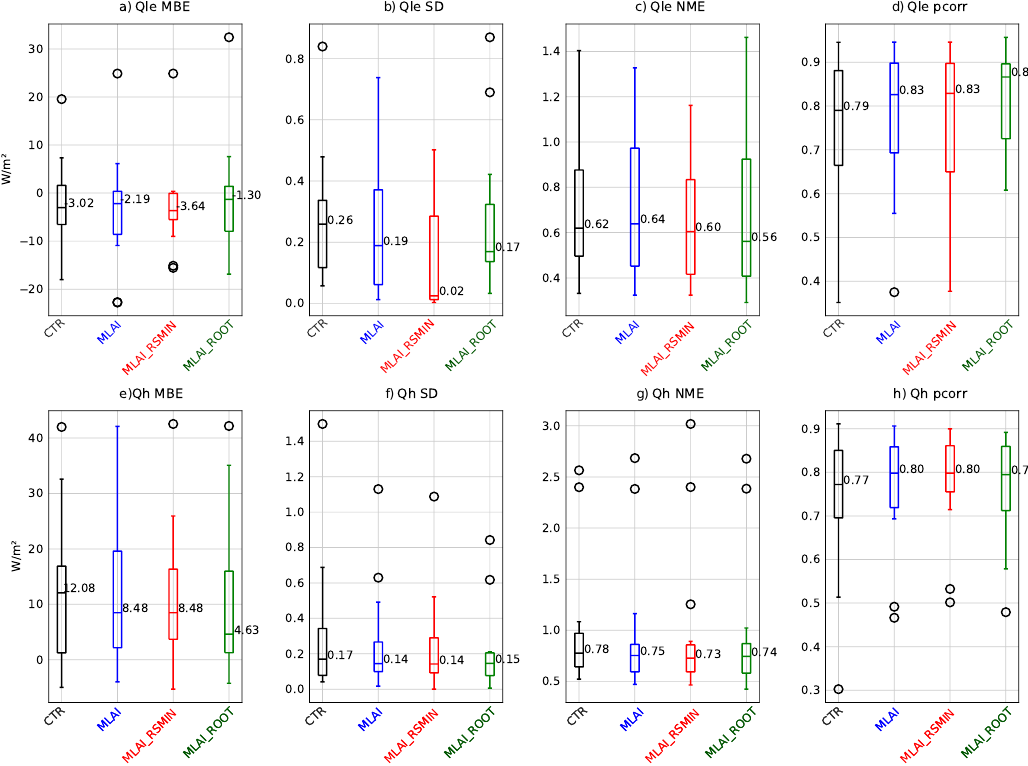
Figure 1. Latent ( a – d , top panels) and sensible ( e – h , bottom panels) heat flux evaluation in terms of mean bias error (MBE), SD, normalized mean error (NME) and r for CTR, LAI, LAI_RSMIN and LAI_ROOT. The boxplots represent each metric’s distribution for the 17 towers showing the percentiles of 25, 50 and 75. Symbols denote outliers for values greater than 1.5 times the interquartile range from the nearest 25th or 75th